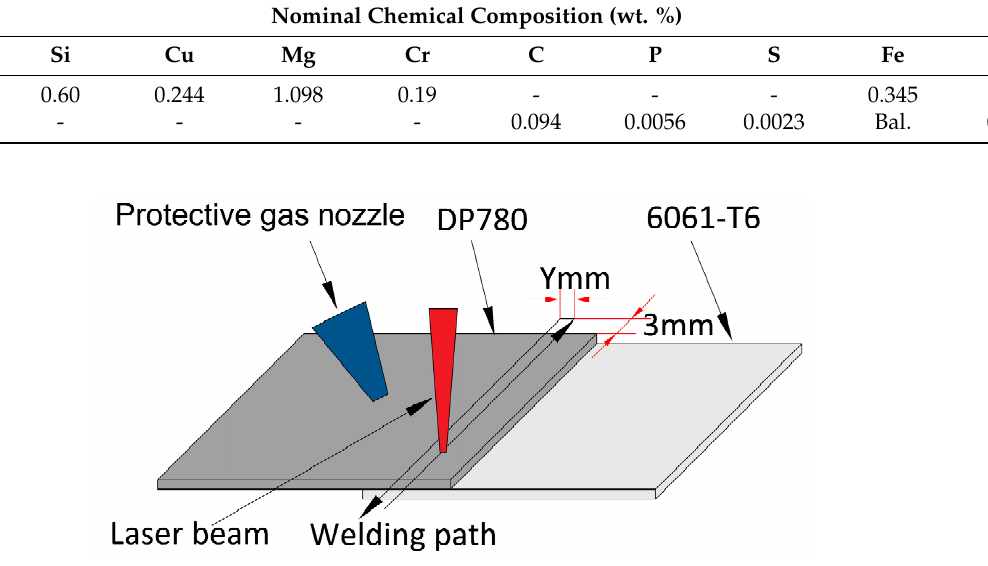
Figure 1. Schematic diagram of laser double-pass reciprocating welding. Table 1. Nominal chemical composition of base metals in wt. %.